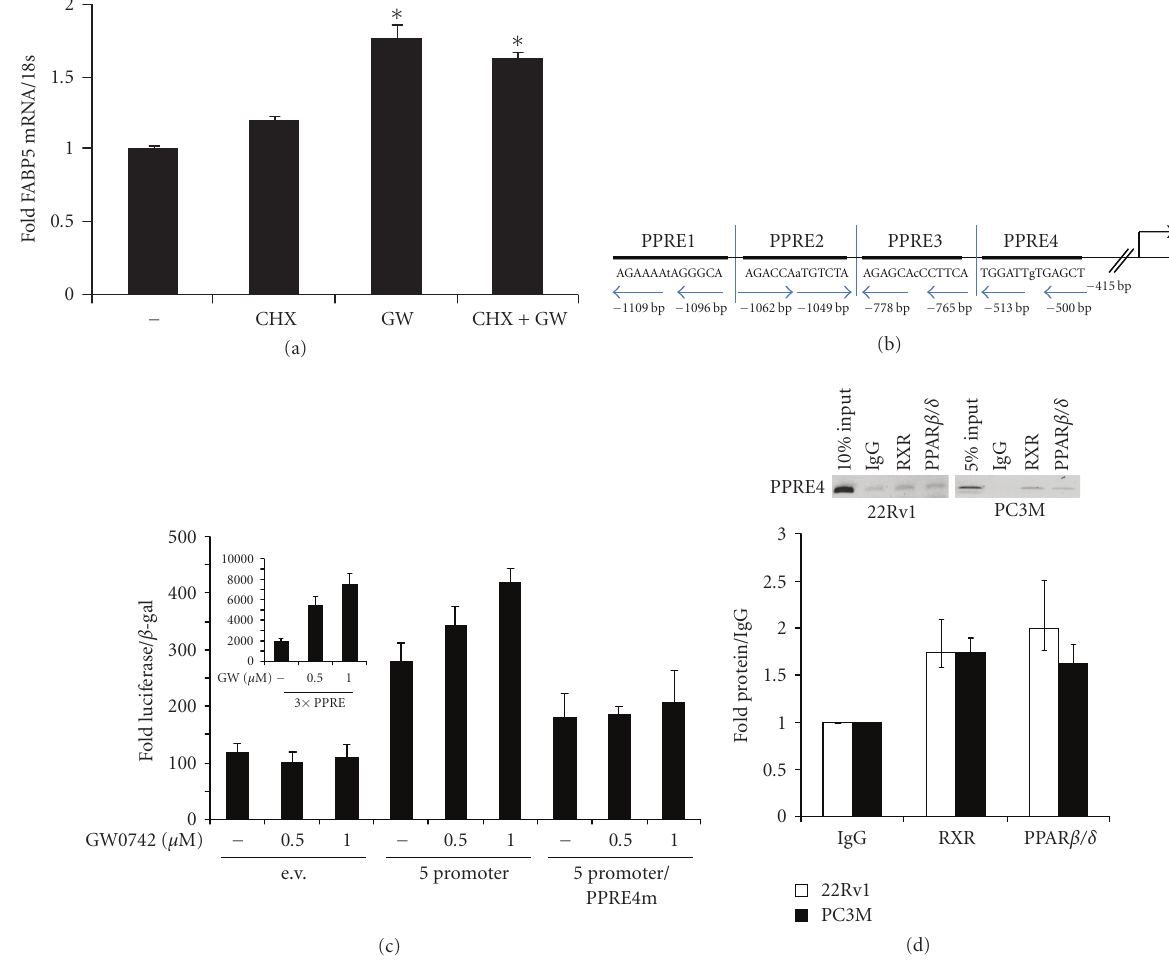
Figure 3: FABP5 is a direct target gene for PPAR β/δ . (a) PC3M cells were treated with cycloheximde (20 μ g/mL) for 10 min prior to addition of GW0742 (1 μ M, 4h). Expression of FABP5 mRNA was measured by Q-PCR. Data are mean ± S.D. ( n = 3). ∗ P < . 05 versus nontreated control. (b) Location of putative PPREs in the FABP5 promoter. (c) Transcriptional activation assays utilizing a luciferase reporter driven by a 900bp region of the FABP5 promoter which encompasses the four putative PPREs (5 promoter). In the mutant reporter construct (5 promoter/PPRE4m), the AGCTCA sequence in PPRE4 was exchanged to AGCTTT. PC3M cells were cotransfected with the denoted reporter and an expression vector for β -galactosidase. 24 h later, cells were treated with vehicle or GW0742 and cultured for 24 hr. Luciferase activity was measured and normalized to the activitiy of b-galactosidase. Data are mean ± S.D. ( n = 3). Inset: Luciferase assays carried out with a luciferase reporter driven by 3 consensus PPREs. (d) Chromatin immunoprecipitation assays in denoted cell lines. Immunoprecipitations were carried out using denoted antibodies and the PPRE4 region of the FABP5 promoter amplified by PCR. Bottom panel: quantification of 3 independent ChiP assays (mean ±